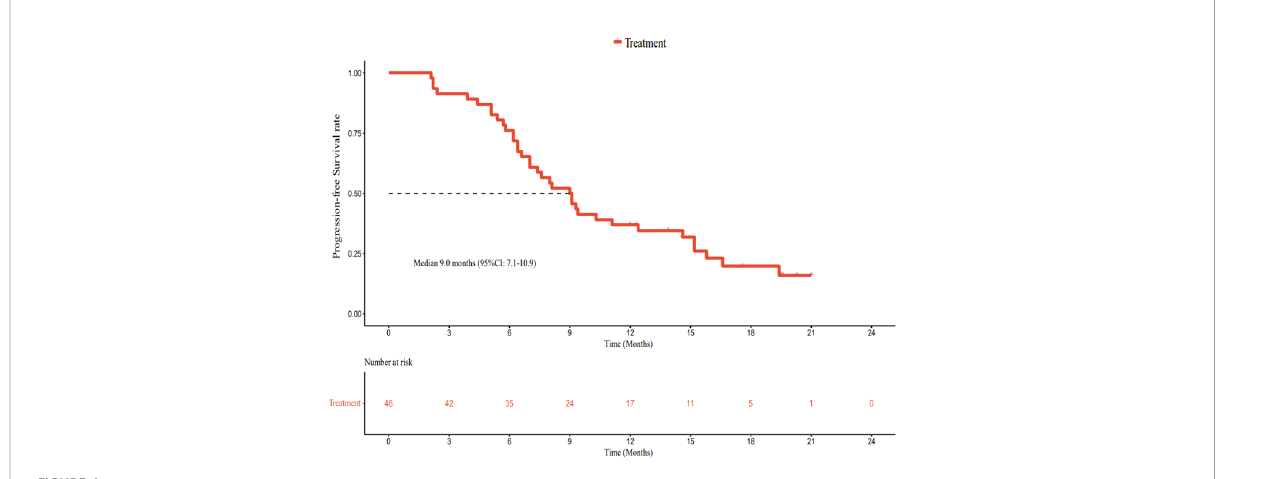
FIGURE 4 Kaplan – Meier plot of progression-free survival.